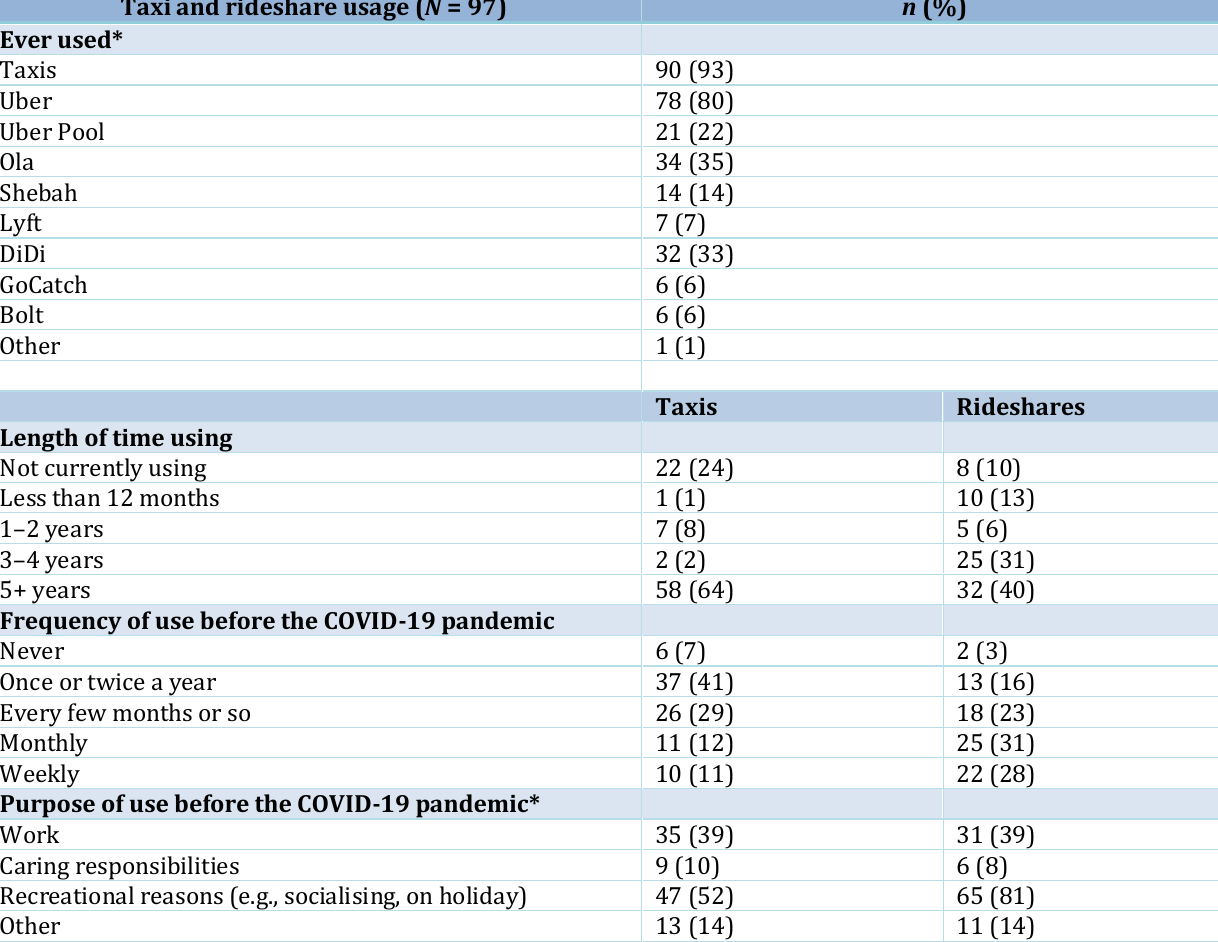
Table 3: Survey participants’ usage of taxi and rideshare services Taxi and rideshare usage ( N = 97) n